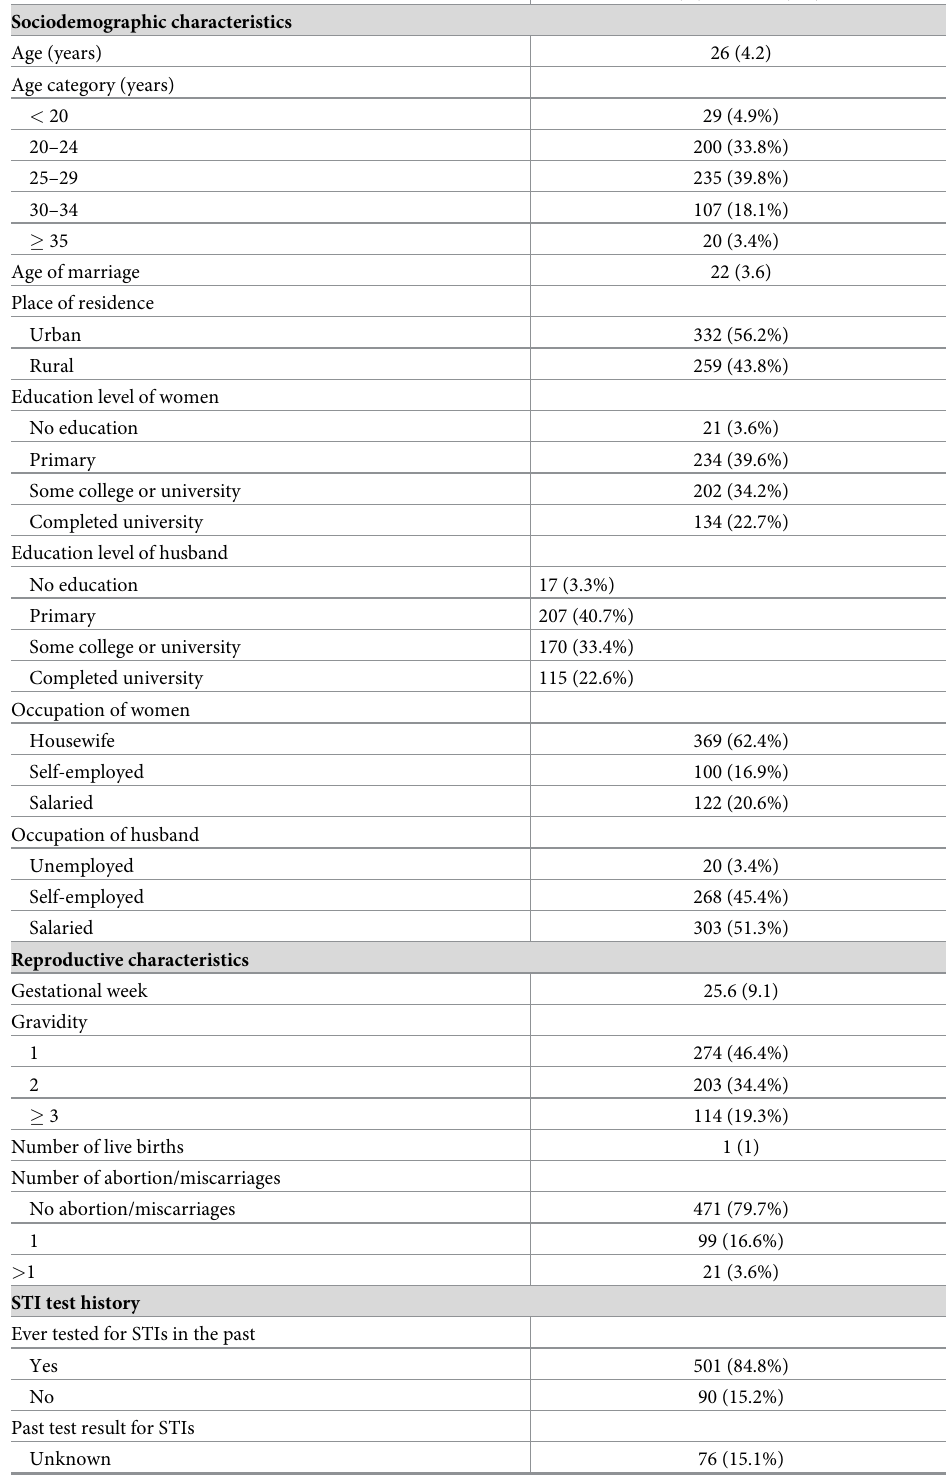
Table 1. Characteristics of pregnant women visiting antenatal care clinic in Dhulikhel Hospital, Nepal (N =